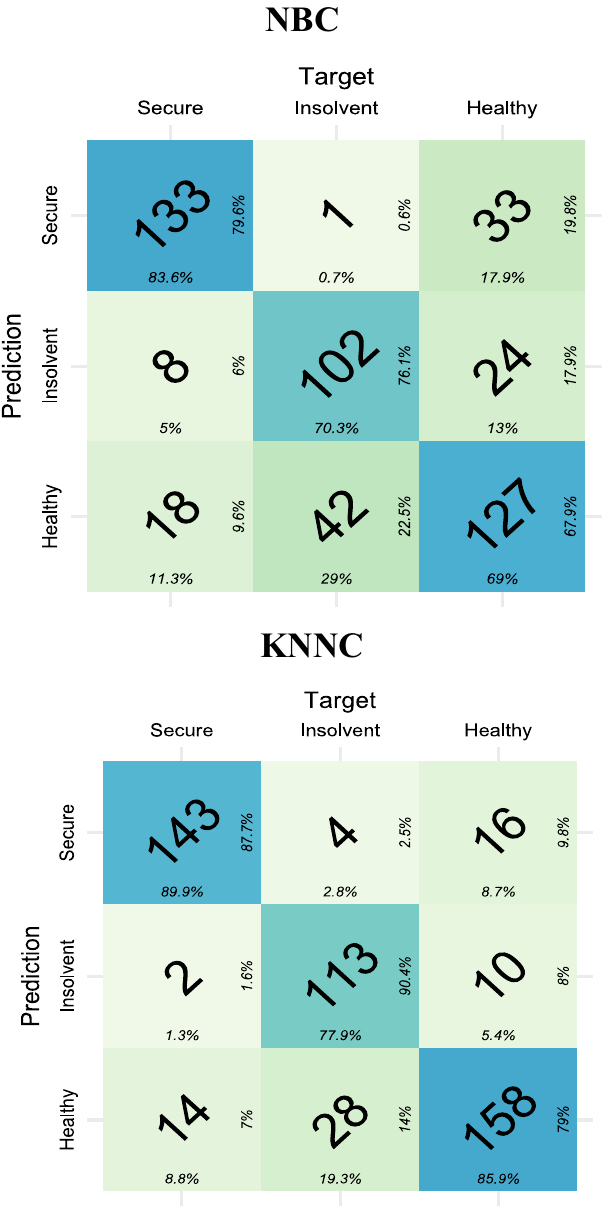
Figure 4. Confusion matrix of NBC and